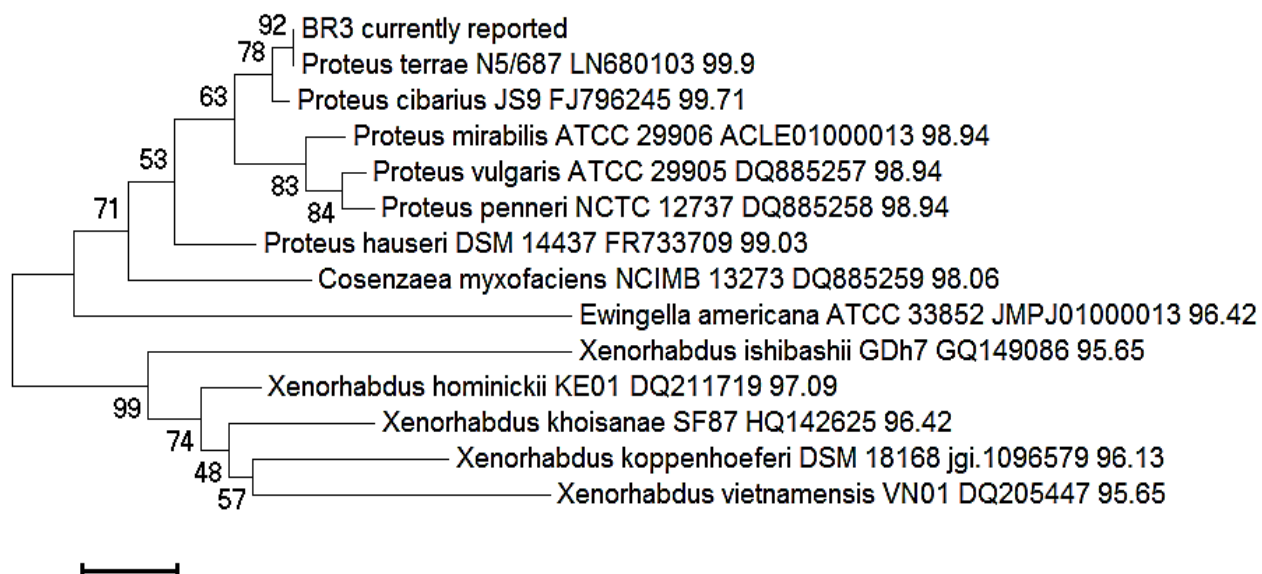
Figure 5. Phylogenetic tree based on 16S-rRNA showing the clustering of BR3 with sequences retrieved form the EzBioCloud database. The tree was constructed in MEGAX by the neighbor-joining method with a 500-bootstrap value.